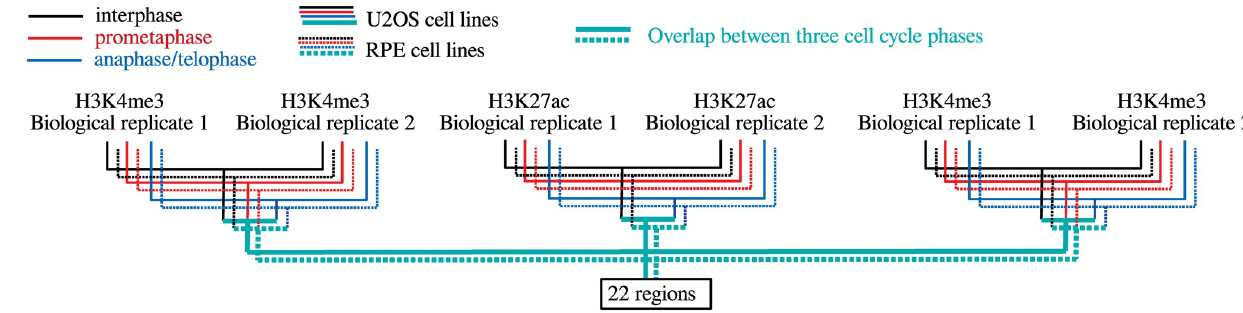
Fig 3. Flow chart on how we integrated peak call